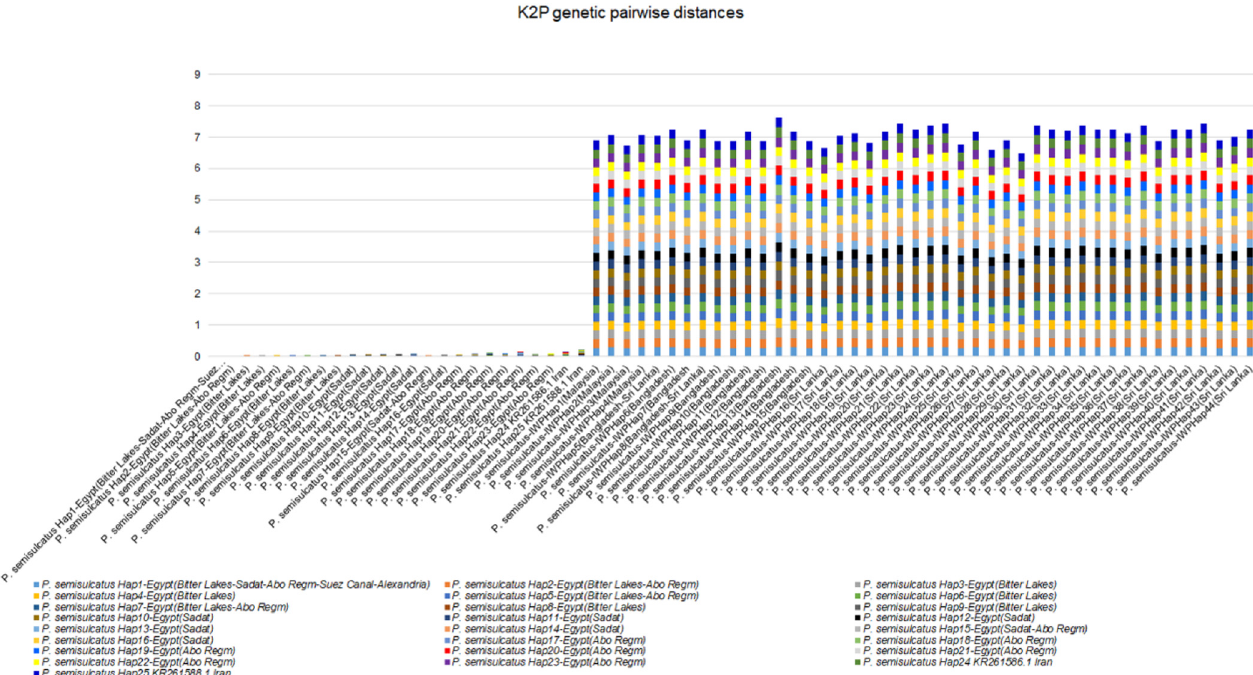
Fig. 8. Distribution of genetic pairwise distances among Gulf of Suez, Arabian Gulf, and Indo-West Paci fi c P. semisulcatus COI haplotypes in comparison to those in the GenBank and BOLD